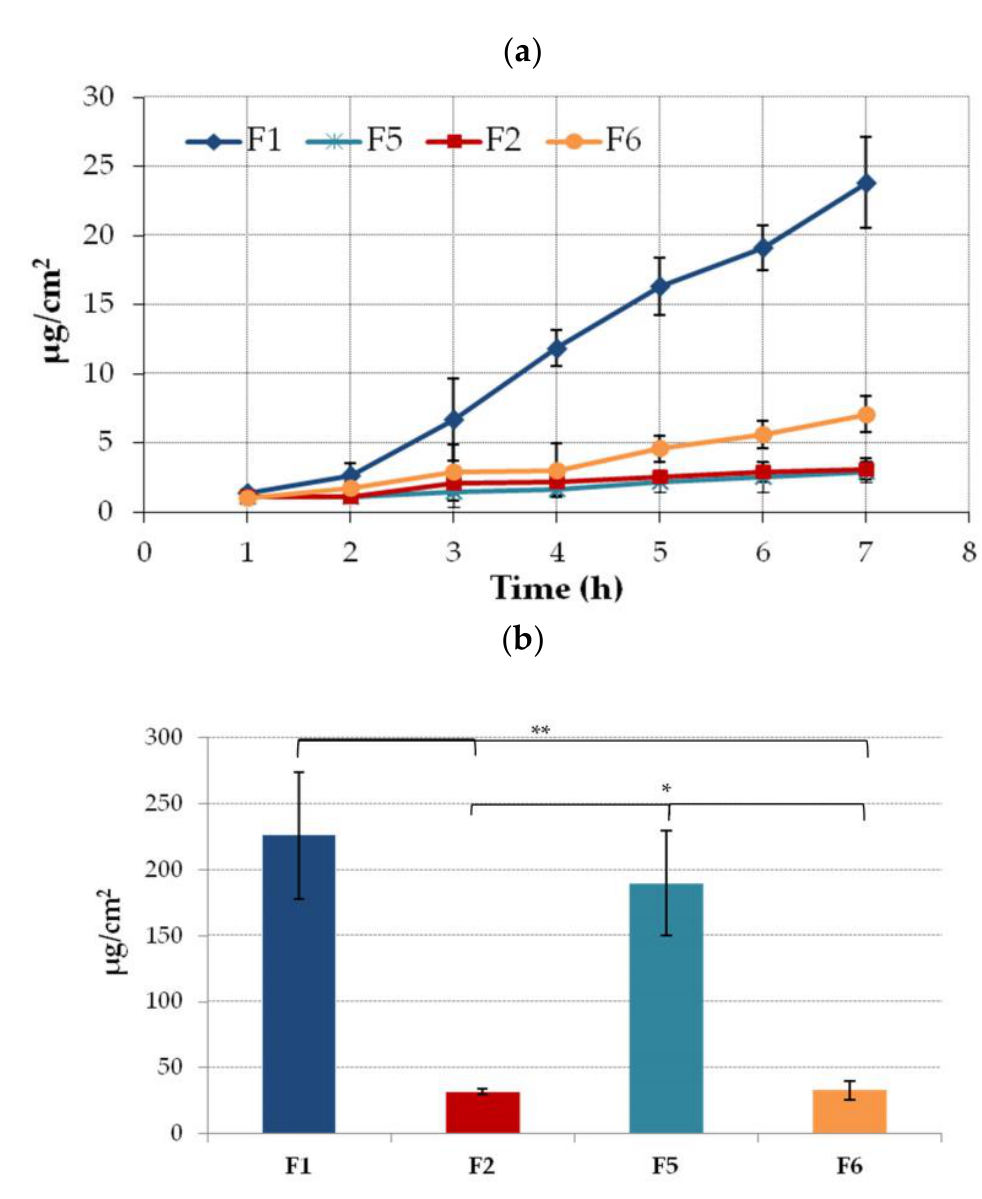
Figure 6. ( a ) Permeation and ( b ) retention (expressed as the amount of drug in the acceptor medium per contact surface area) of ETD encapsulated in the NLC-gel (F1, F2) or ETD suspended in the gel base (F5, F6) through a Strat-M membrane (mean ± SD; n = 4). * and ** represent significant differences with p ≤ 0.01 and p ≤ 0.001, respectively.